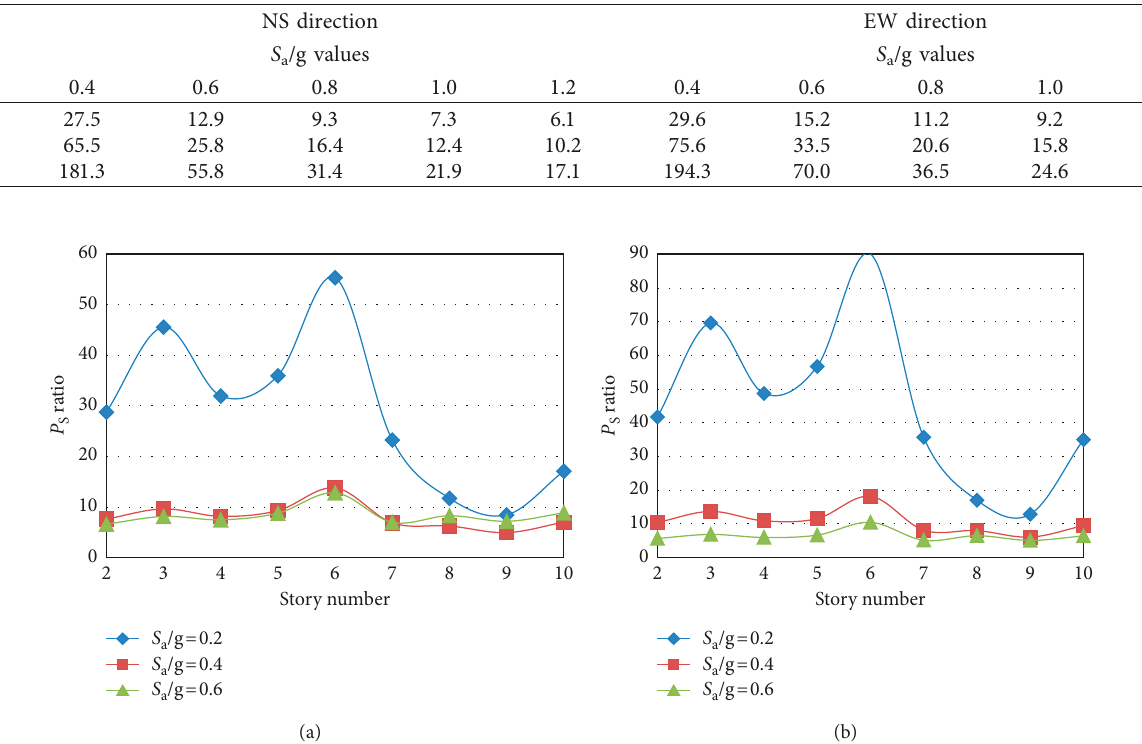
Table 9: P S ratio, 3-level building.